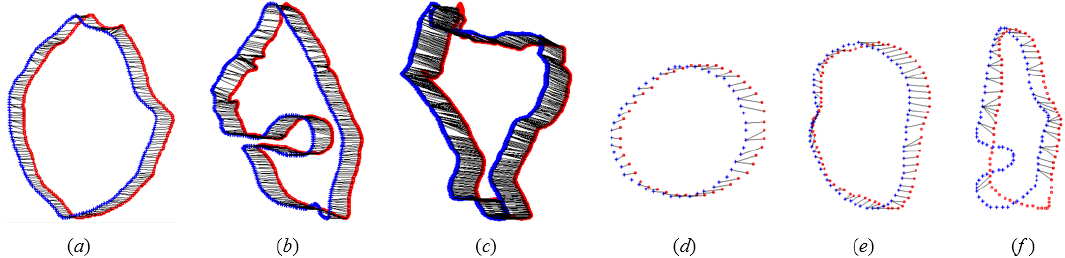
Figure 7. Shape context matching: ( a )–( f ) are six shape pairs with matching results.